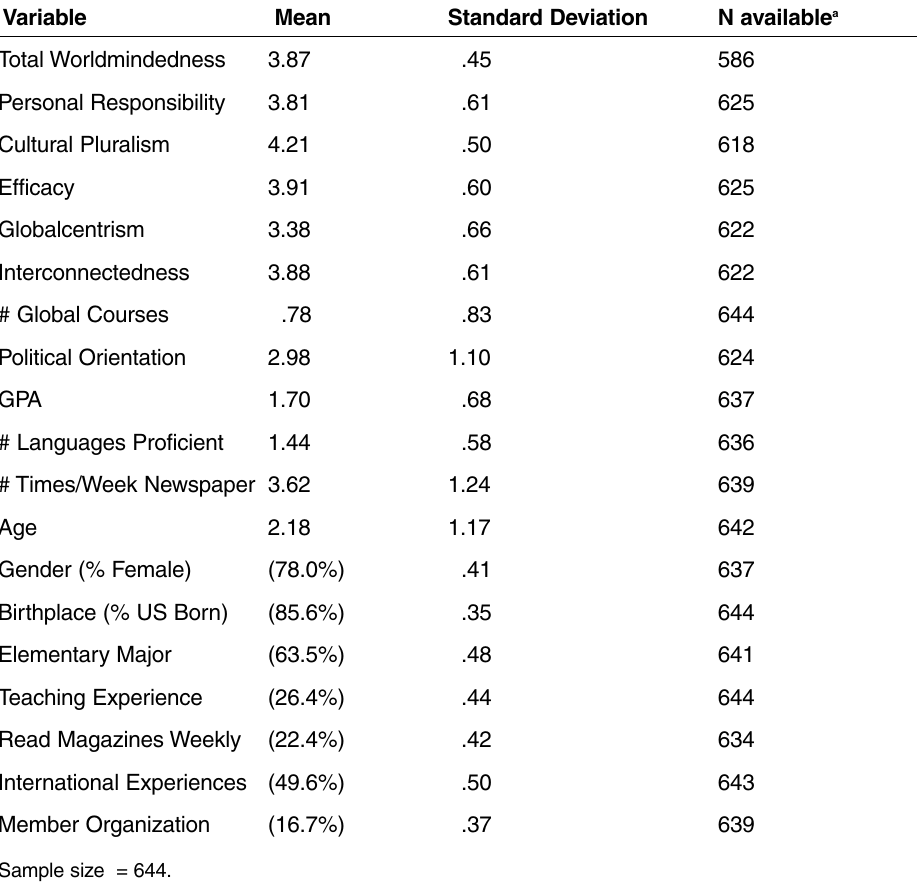
Table 1: Means or Percentages and Standard Deviations